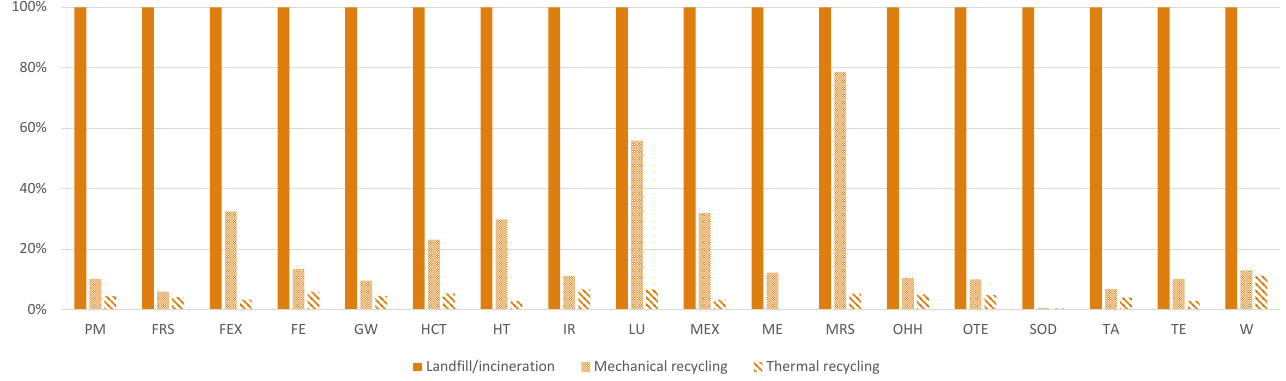
Figure 6. Comparative LCA between EoLs of composites. Incineration and landfill are representative of the most common composite waste management and hence are the baseline of the analysis. Rele- vant reduction in all the impact categories both for the thermal and mechanical recycling pathways. Limited environmental benefits compared to the baseline are shown for mechanical recycling in Mineral resources scarcity